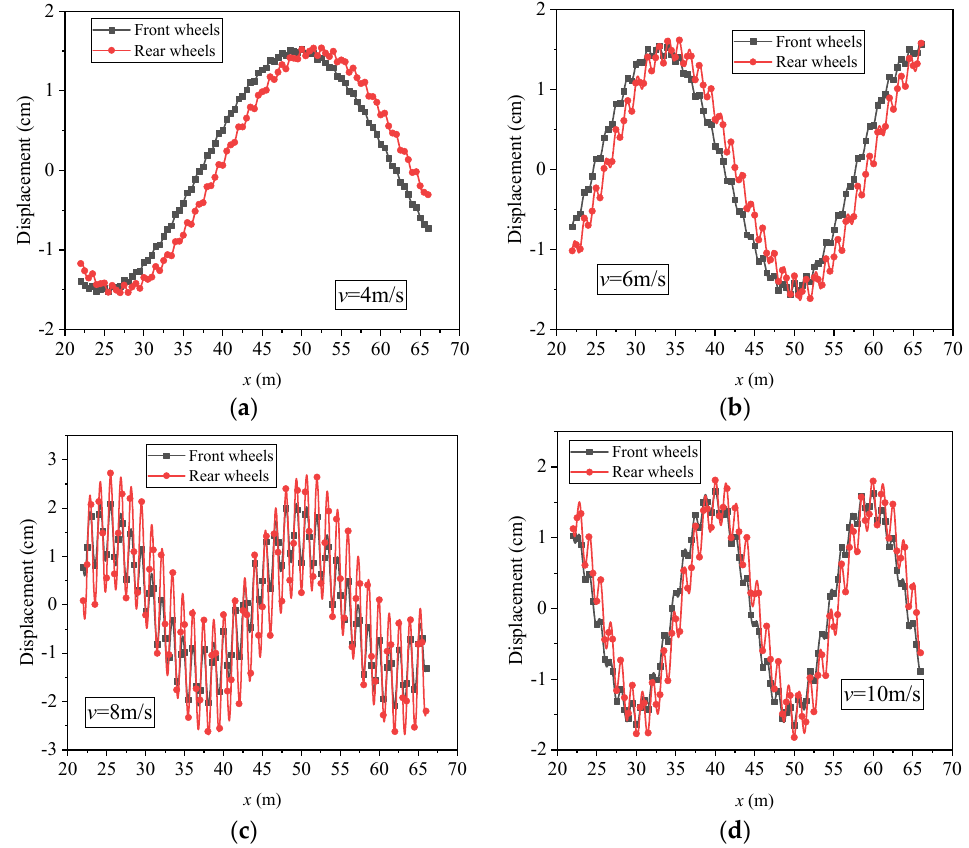
Figure 10. Net displacement of front and rear wheels ( b + c ) ≤ x ≤ 2 ns ( n ∈ N* ): ( a ) v = 4 m/s; ( b ) 6 m/s; ( c ) 8 m/s; ( d ) 10 m/s.